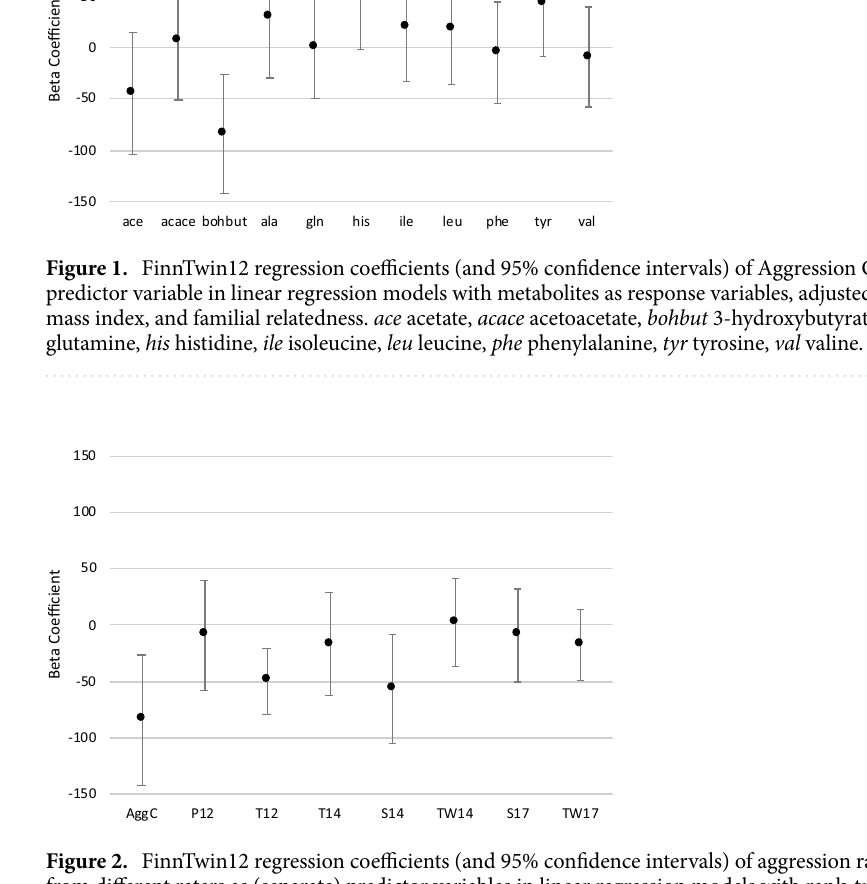
Figure 2. FinnTwin12 regression coefficients (and 95% confidence intervals) of aggression ratings from different raters as (separate) predictor variables in linear regression models with rank-transformed 3-hydroxybutyrate as the response variable, adjusted for age, sex, body mass index, and familial relatedness. AggC aggression combined, P12 parent rating age 12, T12 teacher rating age 12, T14 teacher rating age 14,